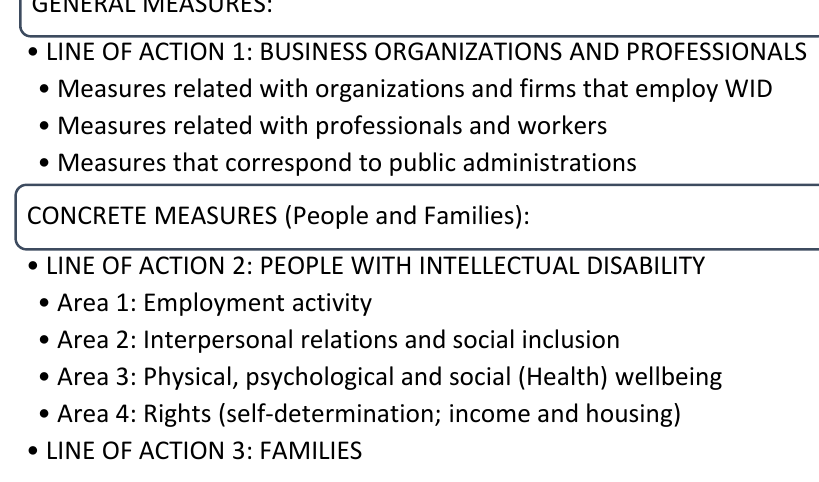
Figure 1. Final schema of the measures.